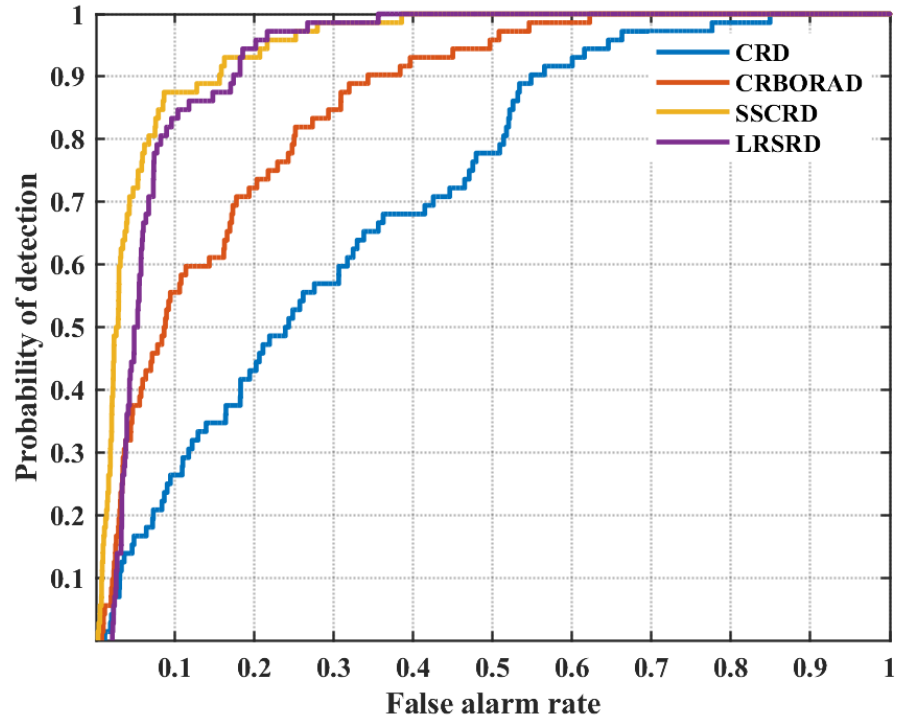
Figure 3. ROC curves for San Diego-I dataset with dual-window sizes (7,11) for CRD, CRBORAD, and SSCRD.